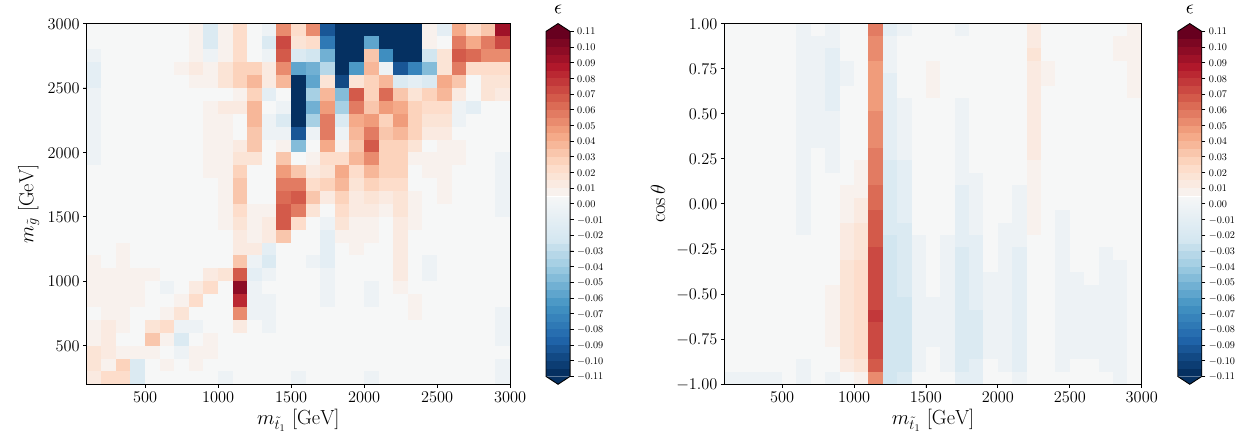
Fig. 22 The relative error between the predicted stop pair-production cross-section in xsec and the Prospino value as a function of the stop mass versus gluino mass (left) and stop mass versus mixing angle (right)